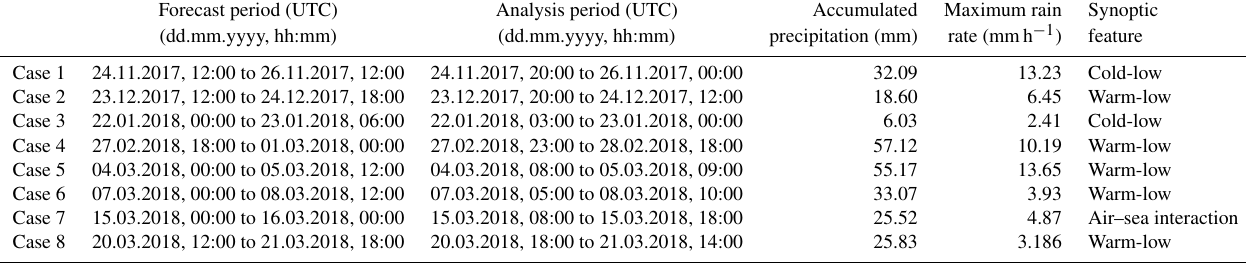
Table 1. Eight selected snowfall events during the International Collaborative Experiment field campaign held at the 2018 Pyeongchang Winter Olympic and Paralympic Games and their characteristics, obtained from the Automatic Weather Station by the Korea Meteorological Administration. Forecast and analysis periods are also noted.